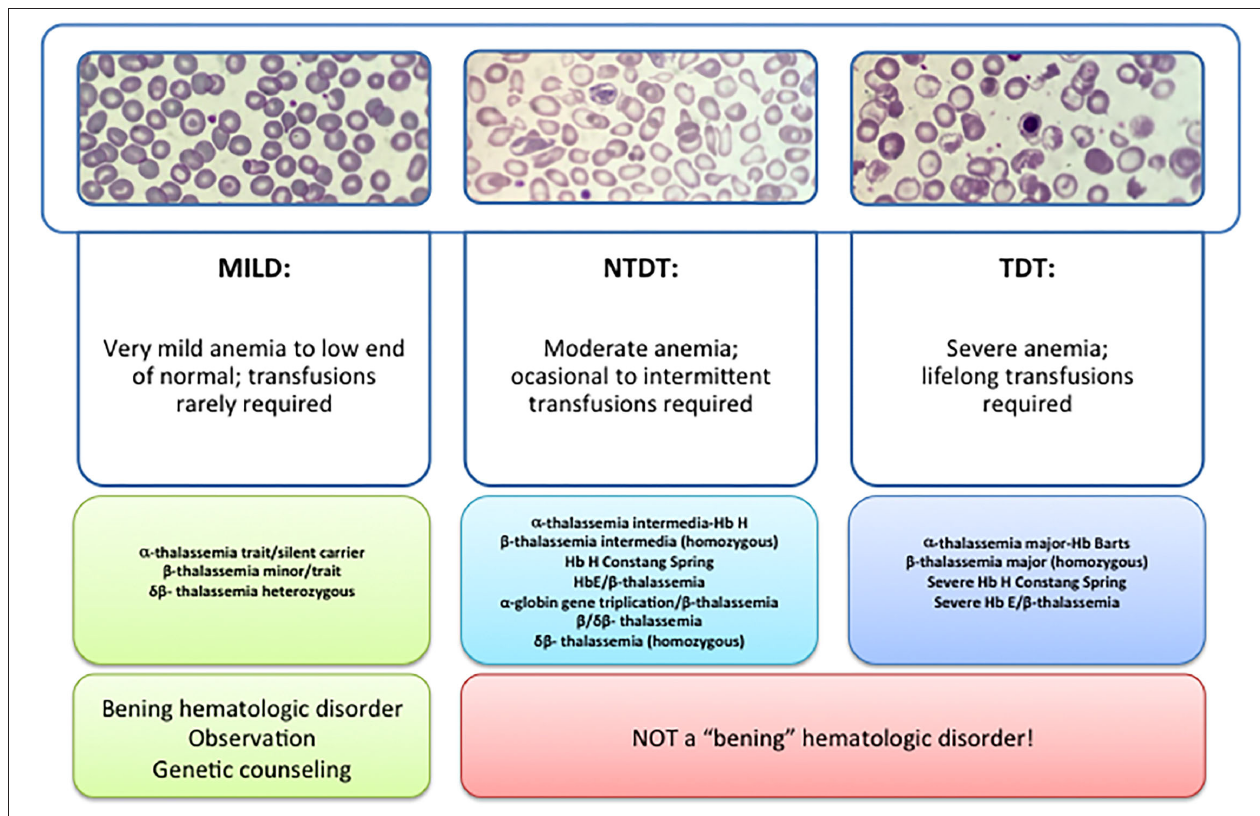
FIGURE 1 | Types of thalassemia. Genotype–Phenotype Association. α and β -thalassemias are genetically heterogeneous diseases. The clinical management with RBC transfusions is an essential factor in classifying them as either transfusion-dependent thalassemia (TDT) or non–transfusion-dependent thalassemia (NTDT). Patients with TDT need life-long regular transfusions for survival in early childhood while patients with NTDT do not need life-long regular transfusions for survival and normally have later in childhood or even in adulthood with mild/moderate anemia that requires only occasional or short-course regular transfusions under concrete clinical circumstances during times of erythroid stress (infection, pregnancy, surgery, or aplastic crisis); however, usually present the typical complications of TDT such as extramedullary hematopoiesis, iron overload, leg ulcers, and osteoporosis. Patients with TDT include those with β -thalassemia major or severe forms of β -thalassemia intermedia, HbE/ β -thalassemia, or α -thalassemia/HbH disease. NTDT mainly encompasses three clinically distinct forms: β -thalassemia intermedia ( β -TI), hemoglobin E/ β - thalassemia (mild and moderate forms), and α -thalassemia intermedia (hemoglobin H